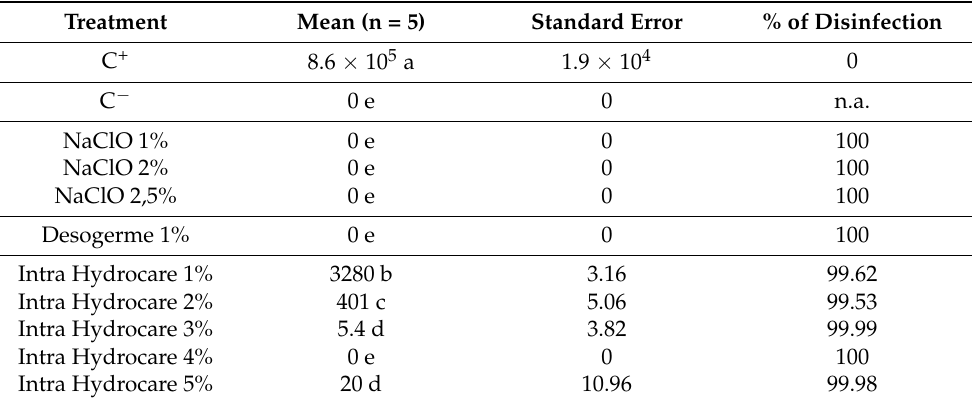
Table 2. Mean of the Fusarium circinatum CFUs per treatment and corresponding percentage of disinfection. Data (n = 5) associated with different letters represent significantly different results in accordance with Dunn’s post hoc test, p < 0.001. The percentage of disinfection was considered non-applicable (n.a.) for the negative control